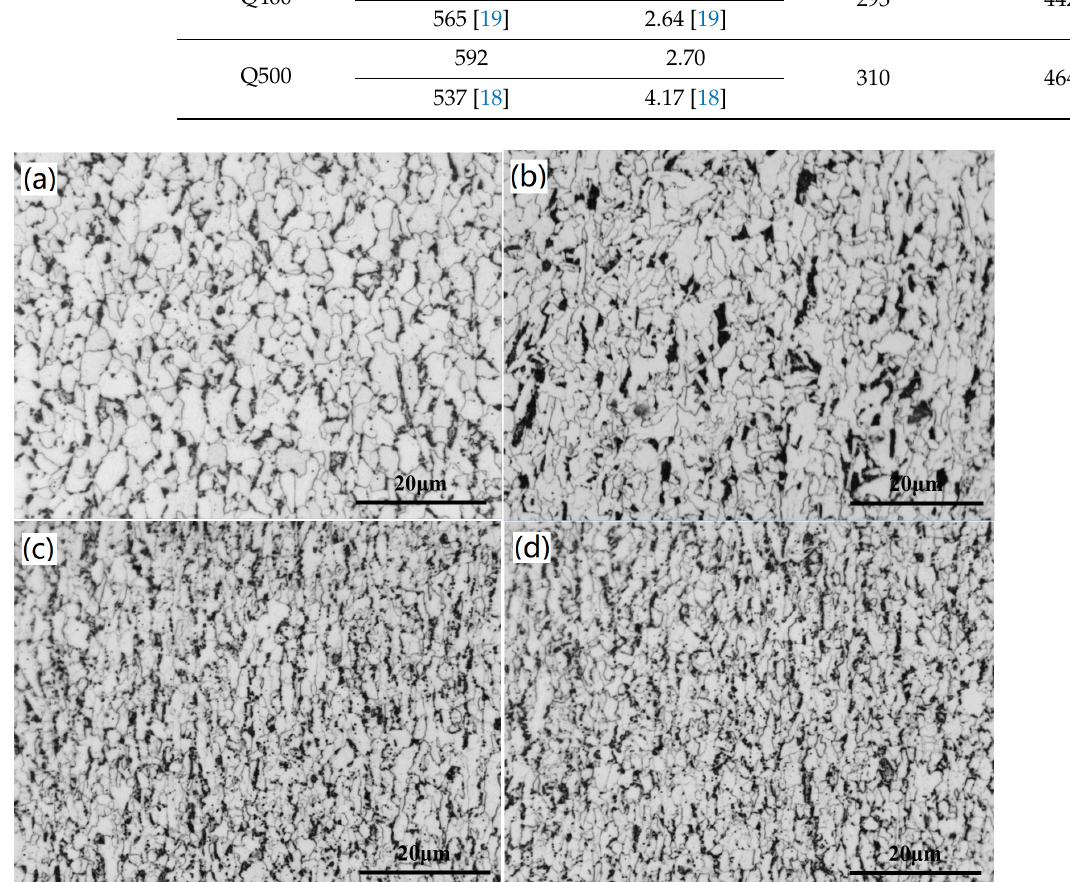
Figure 2. Microstructures of the hot rolled sheets along the rolling direction ( a ) Q380, ( b ) Q420, ( c ) Q460 and ( d ) Q500.